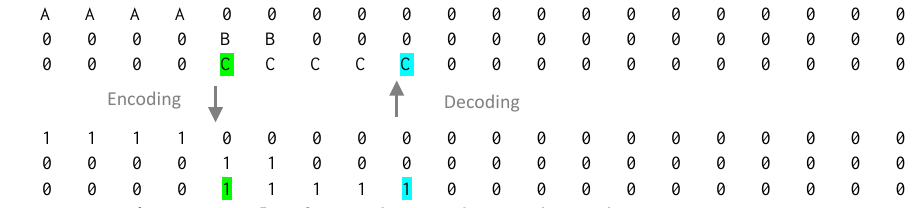
Fig. 3. Sample of Encoding and Decoding Chromosomes Strings